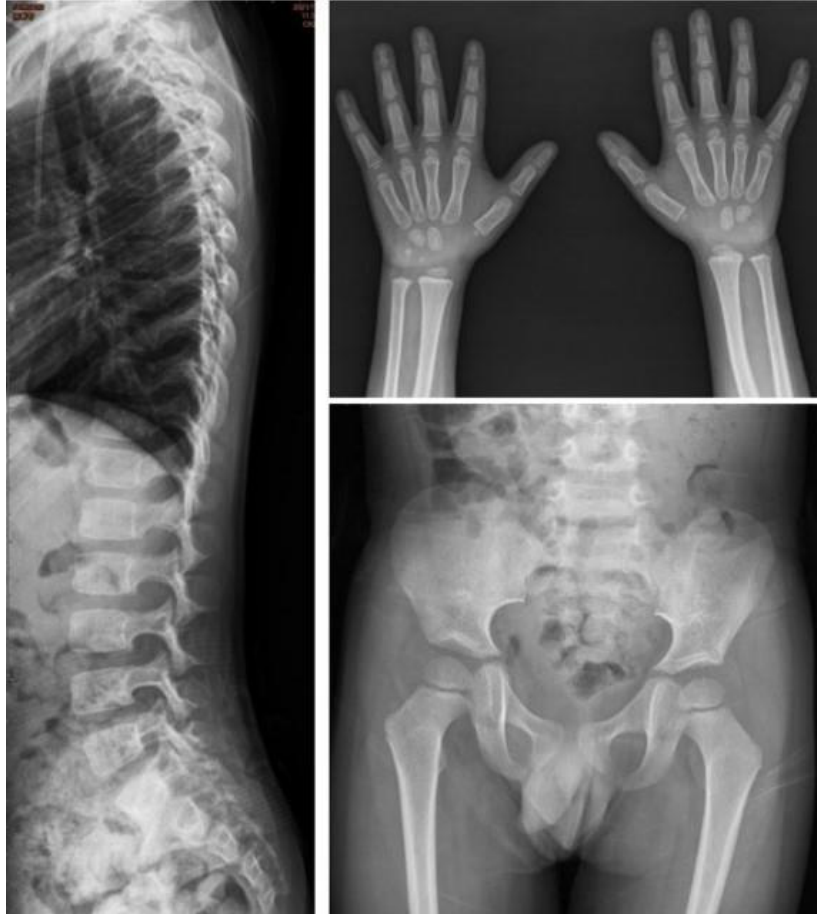
Figure 5. The bone X-rays at 4.3 years of age of patient No. I-2 who had the variation allele c.311A > T [p.D104V]. ERT was started at 1 year of age. He received HSCT at 1.5 years of age. At 4.3 years of age, X-rays of his spine, hands, and pelvis were all normal. 3.4. Variation Allele c.817C > T [p.R273W]